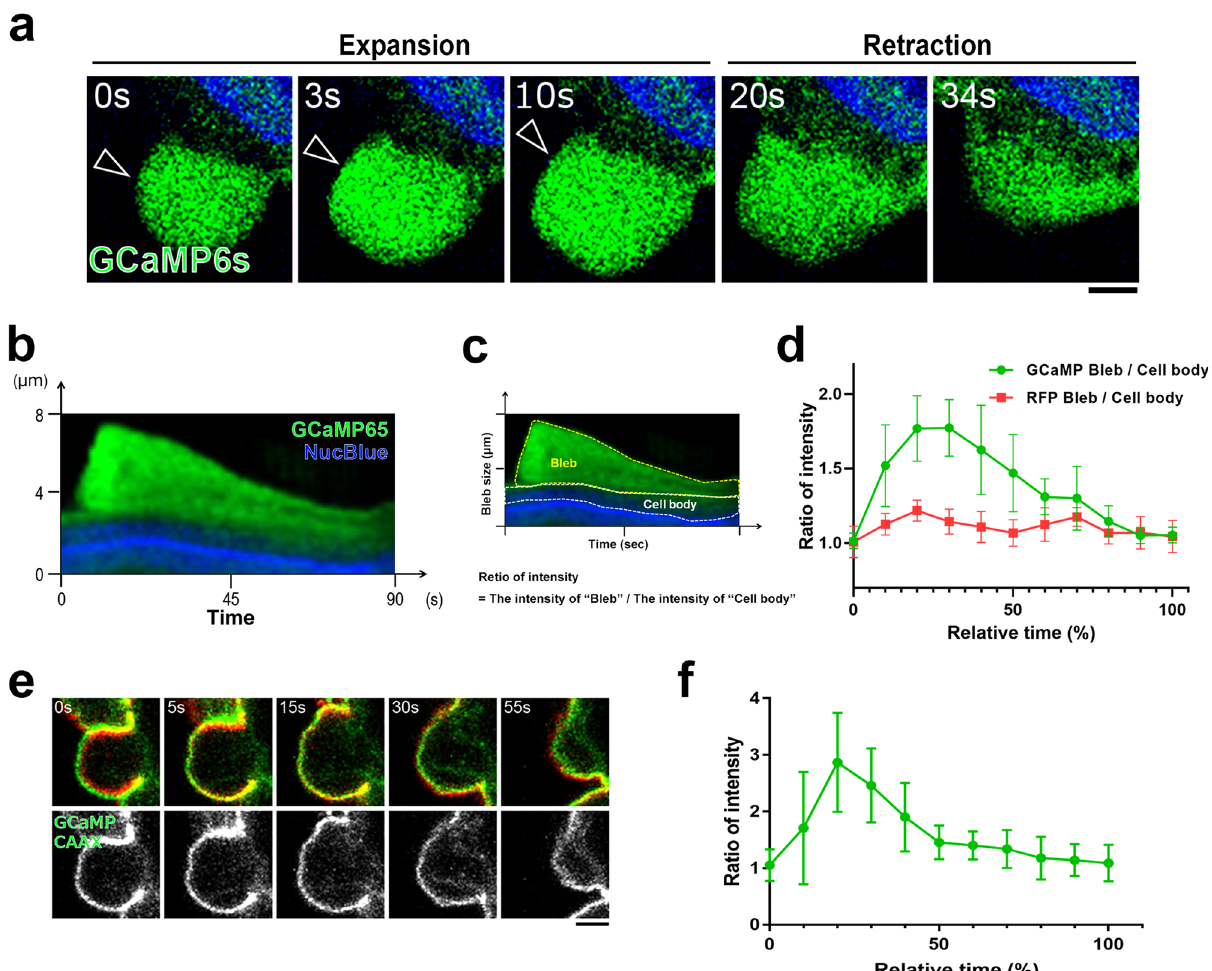
Fig. 2 The concentration of calcium ion increases in the expanding membrane blebs. a Cytoplasmic calcium ion concentration was monitored by expressing GCaMP6s. Arrowheads show expanding bleb. Result shown is representative of fi ve independent experiments. See also Supplementary Movie 3. b – d Kymograph analysis of GCaMP6s in bleb cytoplasm. b Representative kymographs of NucBlue (blue) and GCaMP6s (green) from three independent experiments. Bleb extension is shown on the vertical axis, and time is shown on the horizontal axis. c Schematic of the analysis in d . Fluorescence intensities in “ bleb ” (yellow) and “ cell body ” (white) cytoplasm were quanti fi ed and expressed as ratios. d Fluorescence intensities of GCaMP6s and RFP were quanti fi ed as in c . e , f Calcium ion concentration at the juxtamembrane cytoplasm was monitored with the membrane-targeted calcium probe (GCaMP6s-CAAX; e ). Fluorescence intensities of GCaMP6s-CAAX were normalized to those of mCherry-PLC δ -PH ( f ). Data presented in d and f are means ± SD based on the values from fi ve independent experiments. a and e Indicated times are relative to the fi rst image. Scale bar, 2 μ m. Source data are provided as a Source Data fi